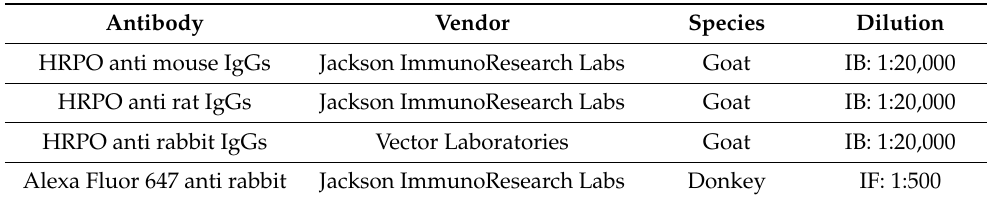
Table 3. Secondary antibodies used in this